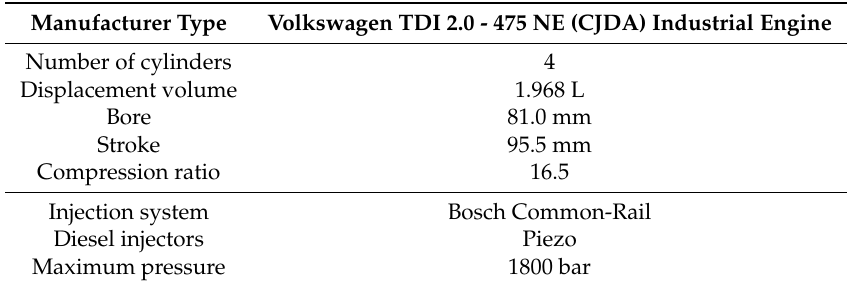
Table 1. Specifications of the basic